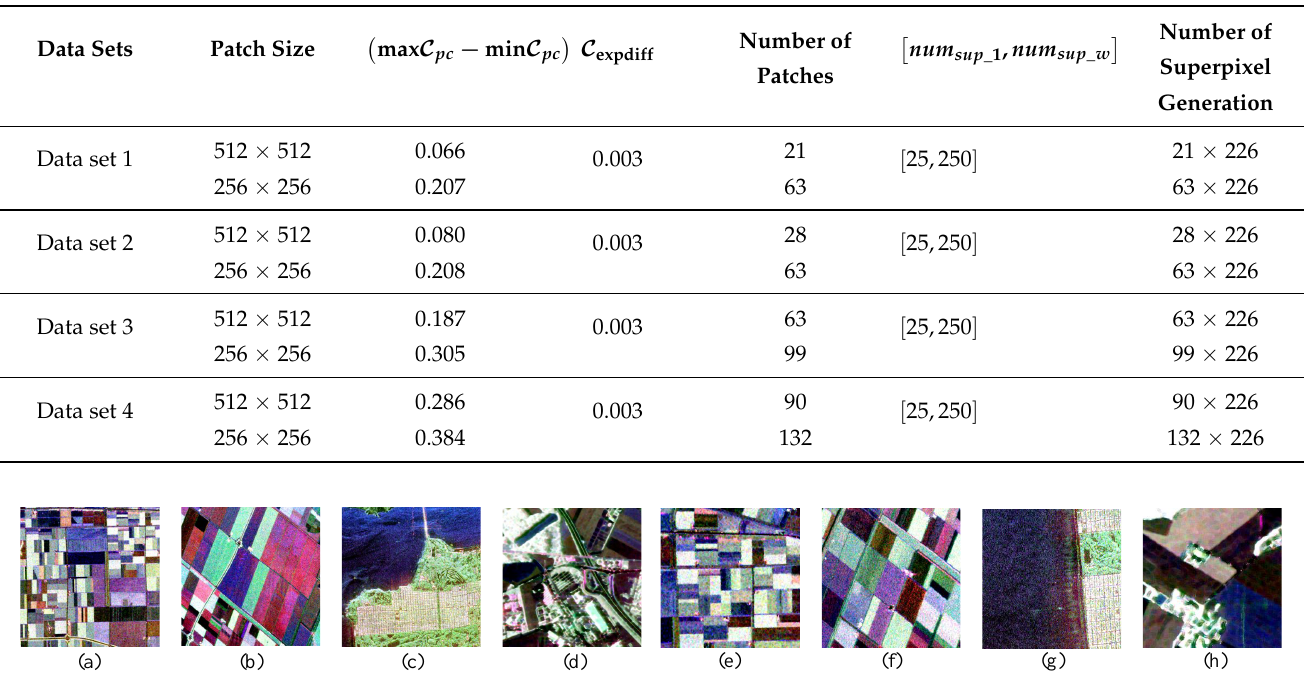
Table 2. Some details of image patches from data sets 1–4.